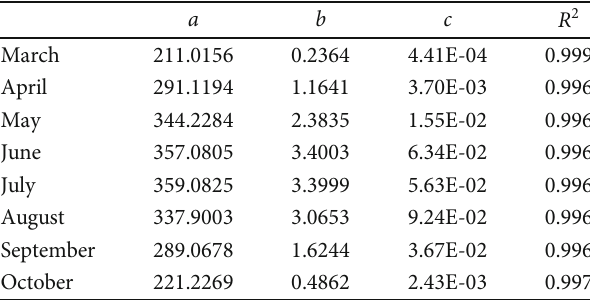
Table 4: Fit parameter